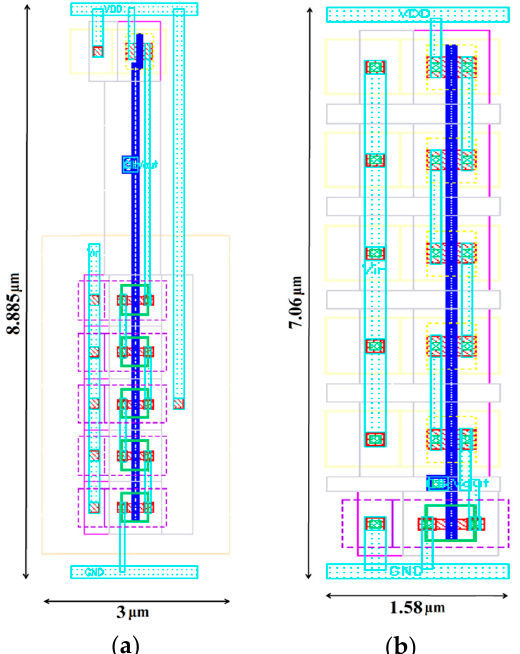
Figure 13. ( a ) Layout of the first proposed VTC circuit. ( b ) Layout of the second proposed VTC